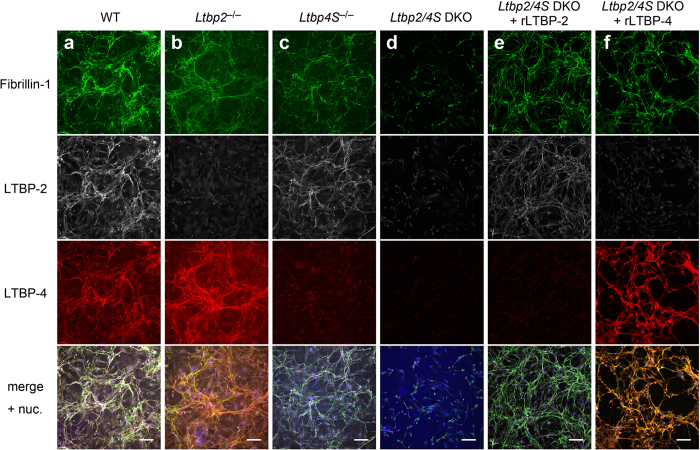
Microfibril formation on cultured MEFs from mutant mice.MEFs of all genotypes were cultured in serum-free media for four days, and the ECM was stained with anti-fibrillin-1, anti-LTBP-2, and anti-LTBP-4 antibodies, followed by fluorophore-labeled secondary antibodies corresponding to each first antibody (green for fibrillin-1, white for LTBP-2, and red for LTBP-4). Nuclei were stained with Hoechst 33258. MEFs lacking either LTBP-2 (b) or LTBP-4S (c) produced a weak but clear fibrillin-1 meshwork as observed in wild type MEFs (a), whereas MEFs lacking both LTBP-2 and LTBP-4S only produced aggregated deposition but no fibrous fibrillin-1–positive meshwork (d). Supplementation of recombinant protein of LTBP-2 (e) or LTBP-4S (f) at a concentration of 5 nM into the cultured medium restored microfibril meshwork formation on Ltbp2/4S DKO MEFs. Bars: 150 μm.